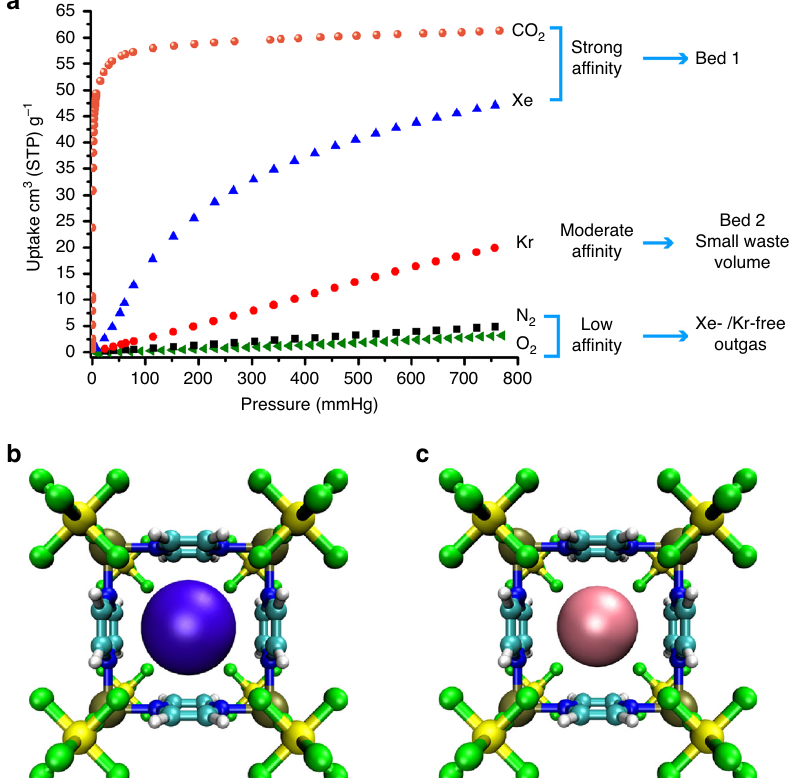
Fig. 4 Gas adsorption properties and binding sites. a Single-component CO 2 , Xe, Kr, N 2 , and O 2 adsorption isotherms at 298 K for SIFSIX-3-Cu. Molecular illustration of the most favorable binding site for b Xe and c Kr in SIFSIX-3-Cu (top view) as determined from simulated annealing calculations. Atom colors: C = cyan, H = white, N = blue, F = green, Si = yellow, Cu = gold, Xe = violet, Kr =